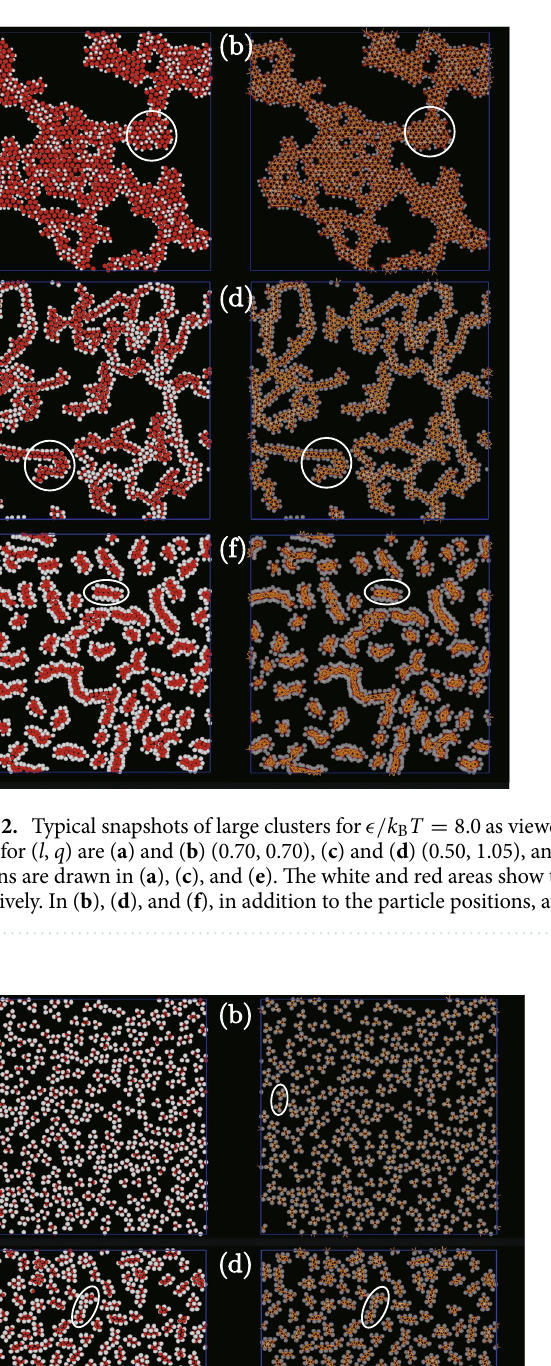
double chain-like clusters need to be curved (Fig. 4k). With a further decrease in q , the curved chain-like clus-